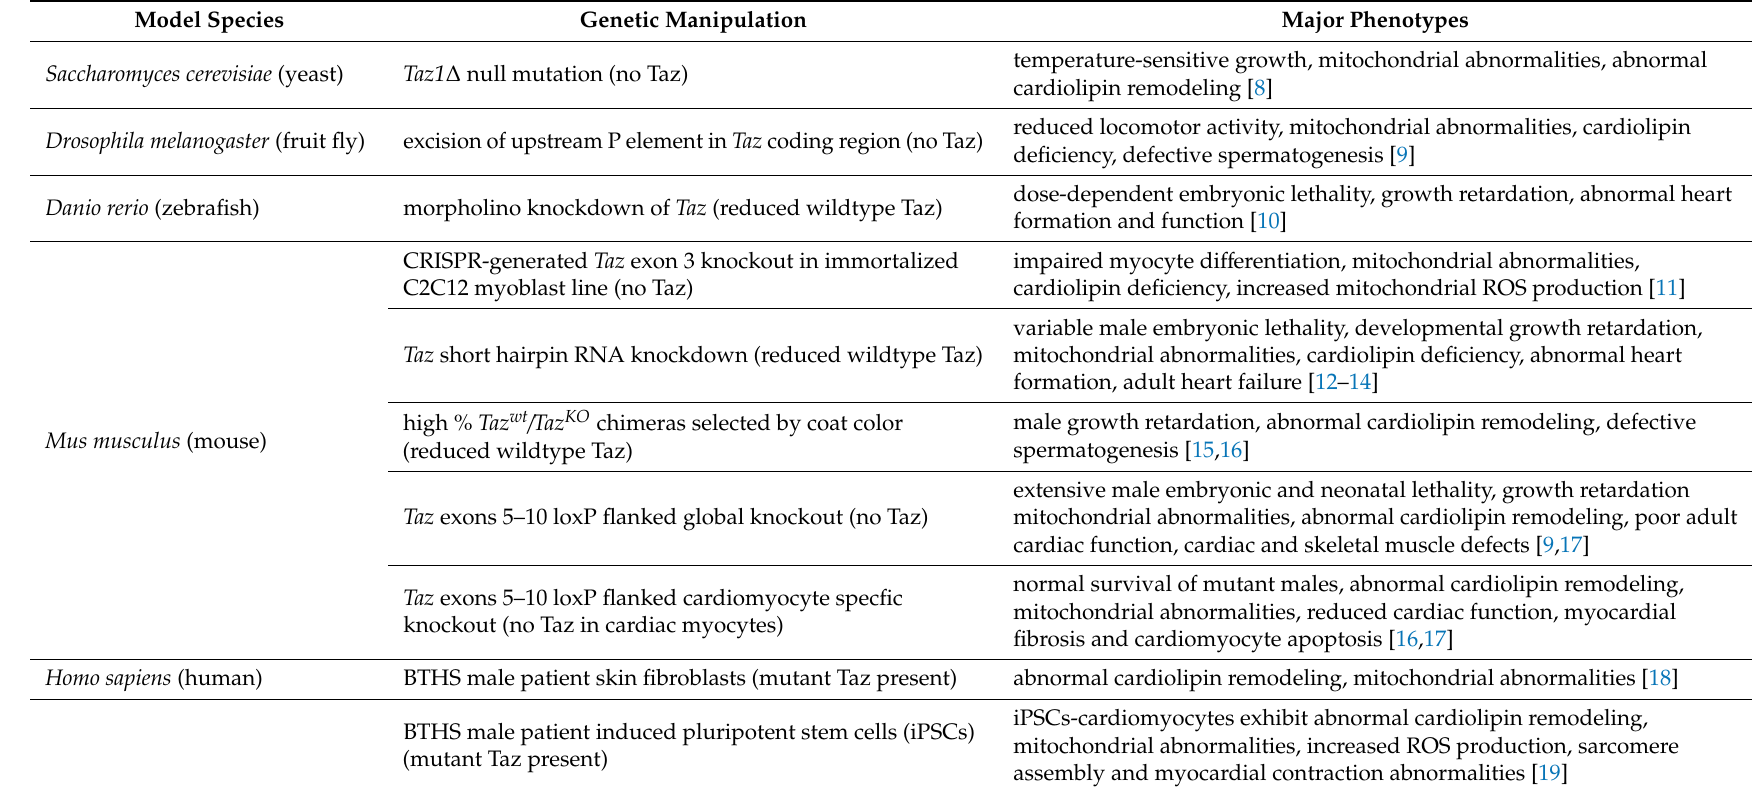
Table 1. Lists the species and their associated major phenotypes, as well as the type of genetic manipulation and whether it results in absent Tafazzin , reduced wildtype Tafazzin or presence of mutant Tafazzin